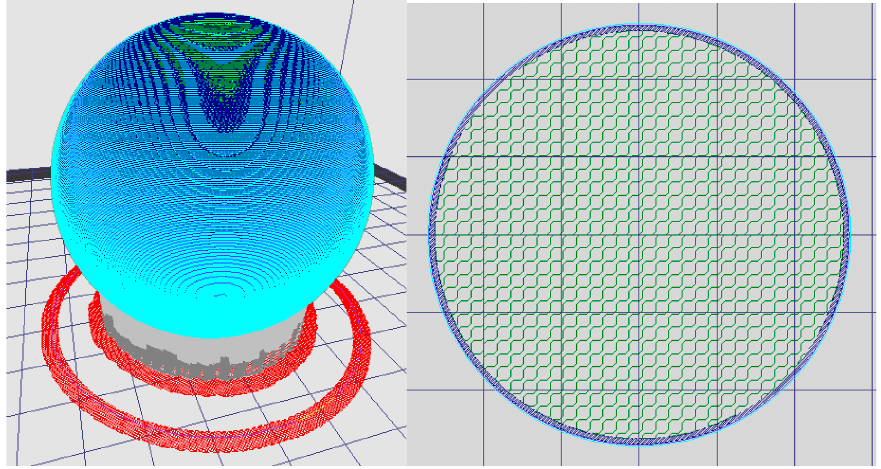
Figure 1. Converting a sphere to STL format depending on the given linear tolerance: from ( a ) the greatest linear tolerance, thru (b) and (c), to ( d ) the smallest linear tolerance [4]. The next step of the process is slicing the part. An exported STL file has to be opened in a Computer Aided Manufacturing (CAM) program, which replaces the continuous net of the triangles with discrete layers/steps and generates the paths of every layer for the head of the 3D printer. The thickness of the layers is chosen depending on the printed material. Screenshots from the KISSlicer v1.6 program of the layers generated by the slicer are shown in Figure 2. Red parts present the first printing layer known as the “skirt”. The grey parts present support, blue—envelope, and green—infill extrusion. When all the parameters of the printing are set, there is time to generate a G-code and send it to the 3D printer [5,6].